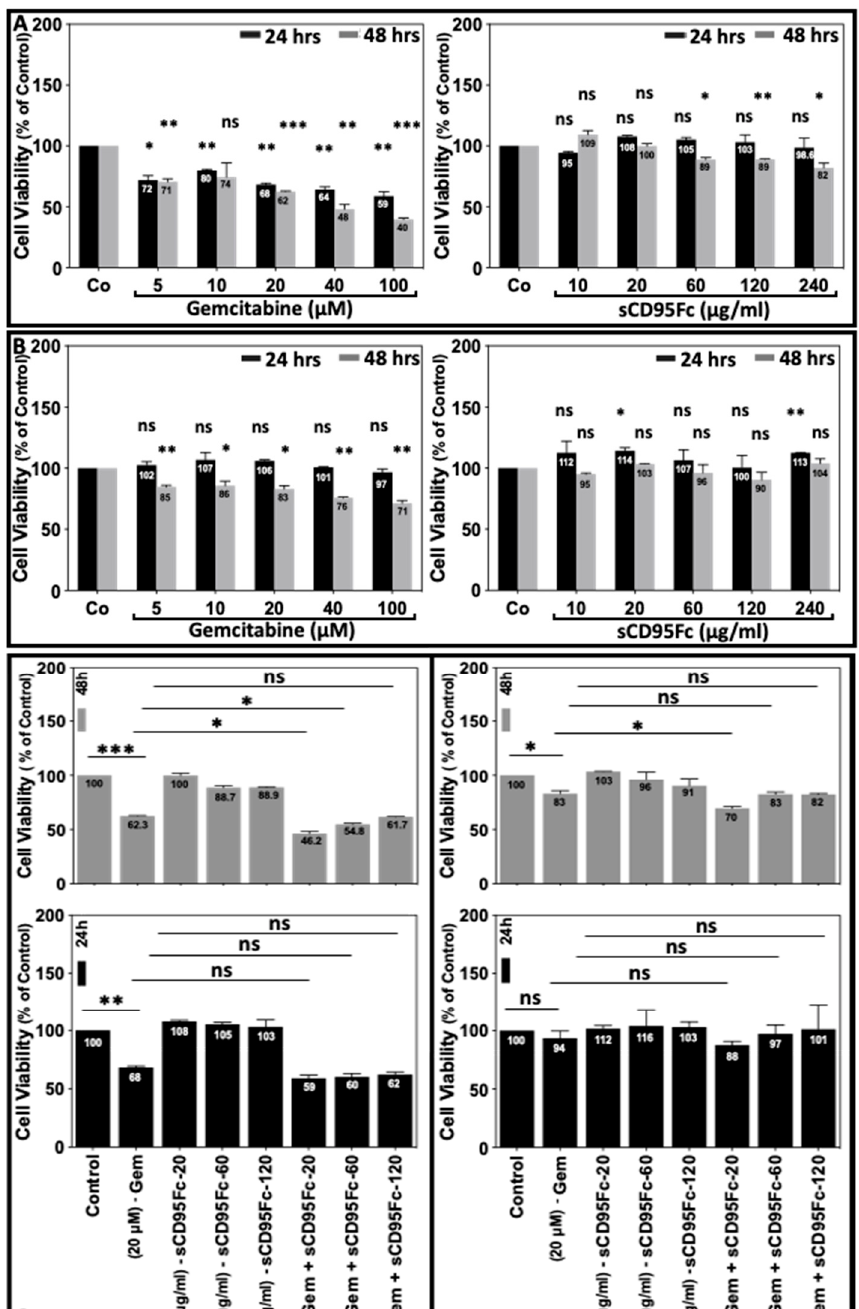
Figure 3. Effect of CD95L inhibition on the gemcitabine-induced cell death of pancreatic tumor cells. Human PDAC cells PancTuI-luc ( A , C ) and A818-4 ( B , D ) were seeded in standard cell culture medium in 96-well plates at densities of 1.0 × 10 4 for a 24 h treatment or 0.7 × 10 4 , respectively, for a 48 h treatment. After initial growth for 24 h, the medium was replaced with fresh medium (100 µ L/well) with escalating concentrations (0 [Control, Co], 5, 10, 20, 40, 100 µ M) of gemcitabine or (0 [Control, Co], 10, 20, 60, 120, 240 µ g/mL) of sCD95Fc ( A , B ) or gemcitabine (Gem-20 µ M) alone or with three different concentrations of sCD95Fc (20, 60, 120 µ g/mL) ( C , D ) for either 24 h (black bars) or 48 h (grey bars). The effect of chemotherapeutic agent and death ligand inhibitors on the cell proliferation was tested by WST-1 assays and is depicted as cell viability as percent of controls (100% untreated cells with WST-1 reagent). Statistical analysis (Student’s t -test) was performed between controls vs gemcitabine (Gem) and Gem vs Gem+sCD95Fc. Each bar represents the mean of two